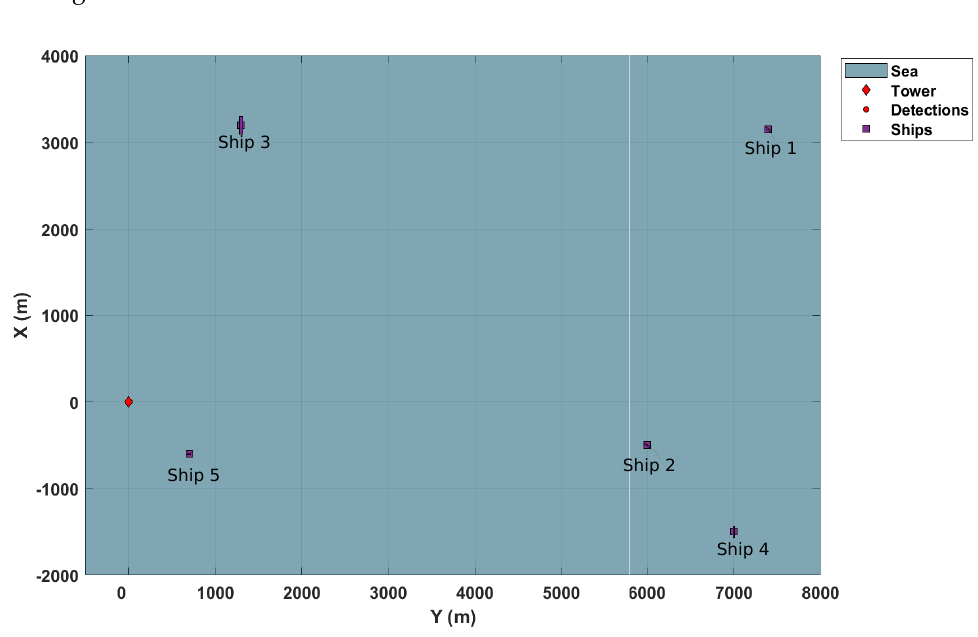
Figure 2. Maritime surveillance